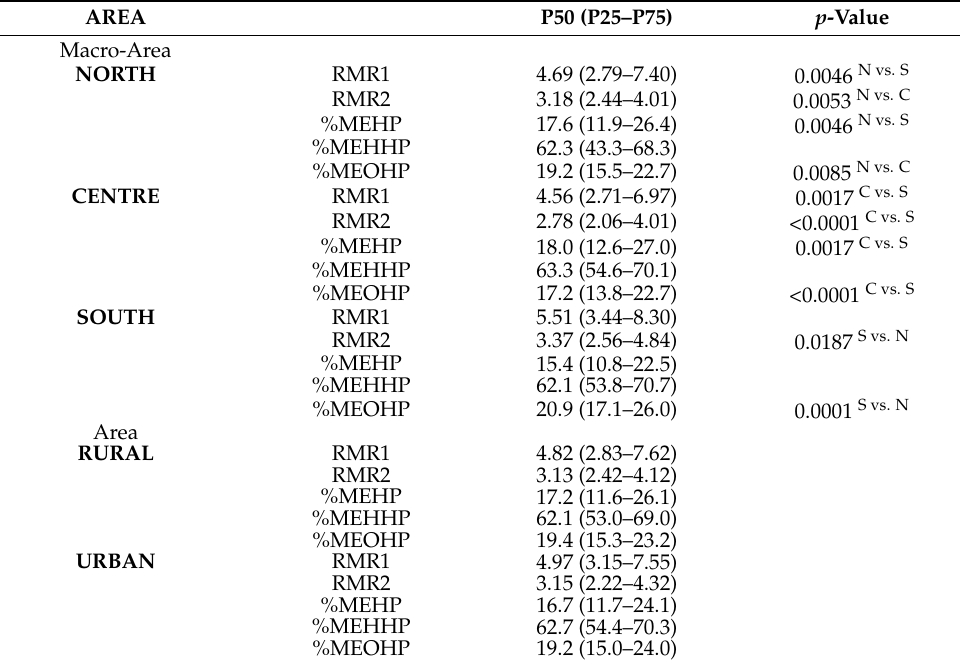
Table 5. Relative metabolic rates and percentage fractions of DEHP metabolites in women residing in the three macro-areas and in rural vs urban areas. Data are expressed as medians (IQ range).